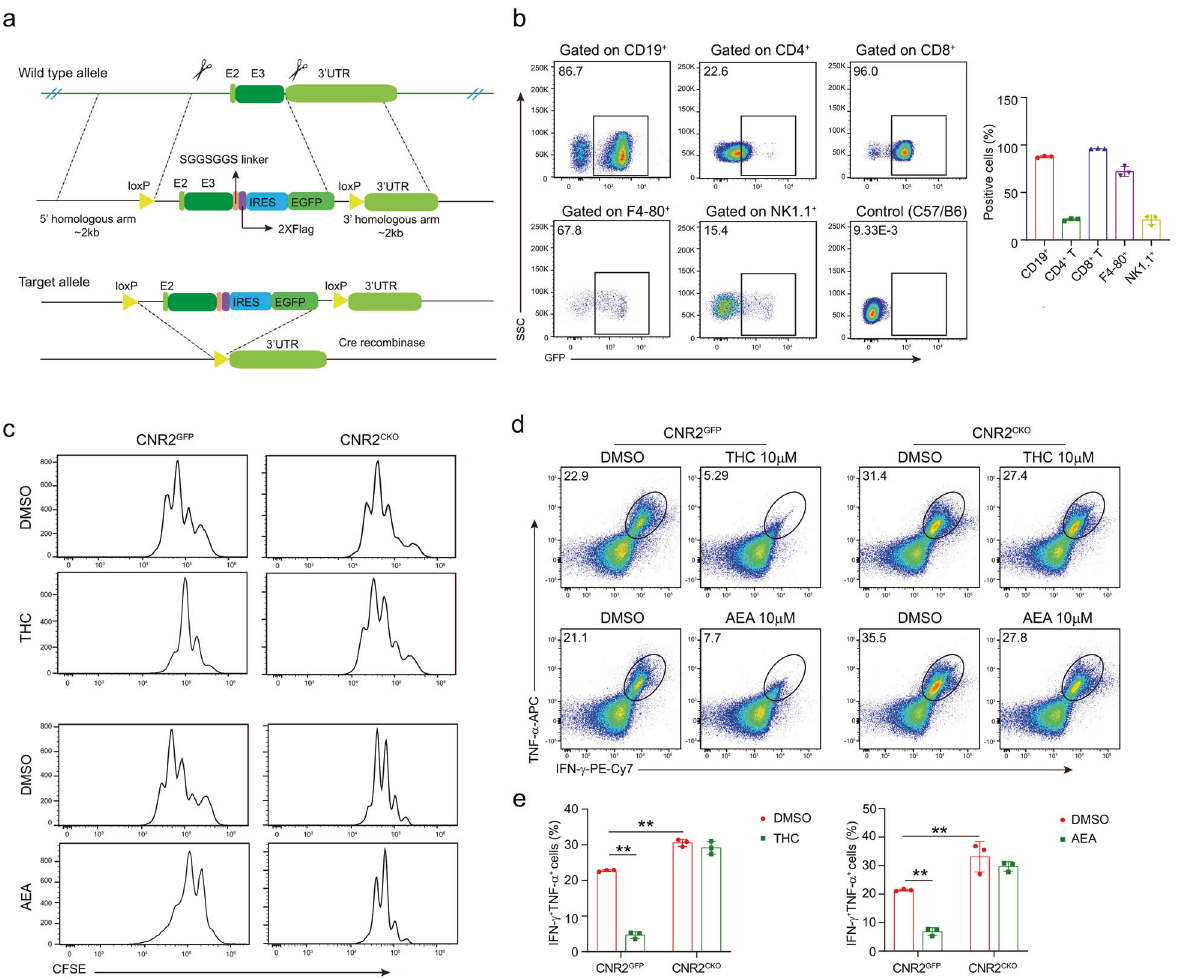
Fig. 3 Cannabinoids impair T-cell-mediated antitumor immunity through CNR2. a Schematic diagram depicting the strategy used to generate Cnr2 condition knockout ( Cnr2 CKO , CNR2 fl ox/ fl ox CD4 cre ) mice (E: exon). LoxP sites fl anking exon 2 of Cnr2 are indicated. Cnr2- 2x Flag- IRES -Egfp fl ox/ fl ox mice ( Cnr2 GFP ) were crossed with CD4 cre mice to delete the second exon of Cnr2 . b Flow cytometry analysis of CNR2 expression from CNR2-GFP reporter mice in immune cell subsets, showing B cell (CD45 + CD3 − CD19 + ), T-cell (CD45 + CD3 + CD4 + /CD8 + ), macrophage (CD45 + CD3 - F4-80 + ) and NK cell (CD45 + CD3 − NK1.1 + ). Cells from wild-type C57BL/6J mice were served as the negative control. Cnr2 GFP and Cnr2 CKO CD8 + T cells were treated with AEA or THC and stimulated by anti-CD3 plus anti-CD28 for 48 h. DMSO was used as the negative control. c Proliferation